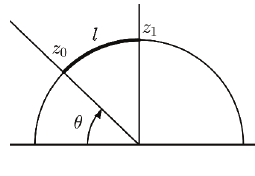
Figure 5. Illustration for Equation (3).